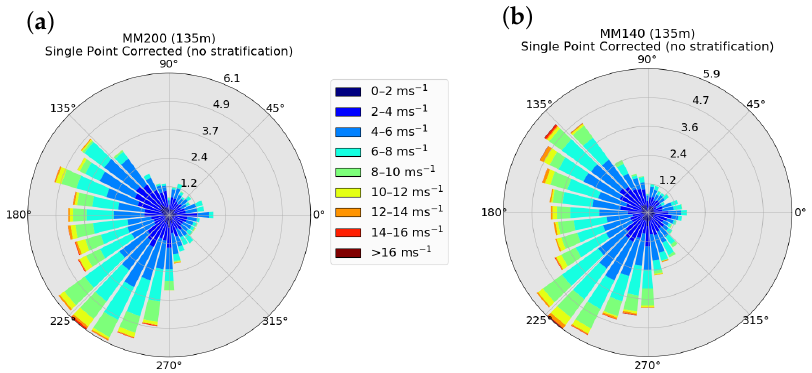
Figure 10. Corrected wind roses from single point downscaling at MM200 ( a ) and MM140 ( b